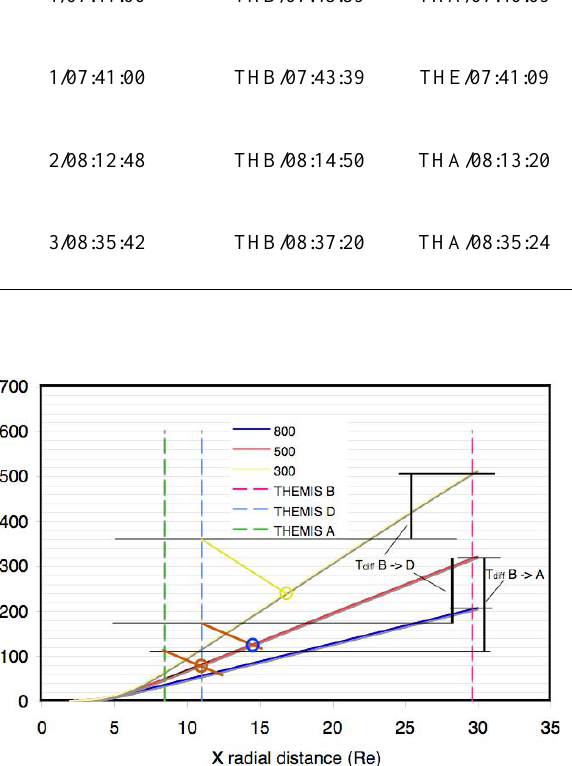
Figure 11. The three curves represent models of the integrated 1/v with 300, 500 and Fig. 11. The three curves represent models of the integrated 1/v with 800 km/s iono-acoustic speeds (yellow, red and blue). The satellite positions for the 300, 500 and 800km/s iono-acoustic speeds (yellow, red and blue). 07:41:00 event of THEMIS A, D, and B are illustrated by the green, blue and red vertical The satellite positions for the 07:41:00 event of THEMIS A, D, and dashed lines. The time difference T diff between the magnetic signature arrivals shown B are illustrated by the green, blue and red vertical dashed lines. The with the black vertical bars. Following the graphical method of deriving X=0 and T= 0 from the signature arrival difference between satellite B and A we can show that using time difference T diff between the magnetic signature arrivals shown the 500 km speed curve X=0 was at 11 Re and is illustrated with a red circle. The blue with the black vertical bars. Following the graphical method of and yellow circles represent the same calculation for the time difference between D and deriving X =0 and T =0 from the signature arrival difference between A for 500 and 300 km/s curves respectively satellite B and A we can show that using the 500km speed curve To examine the inconsistency between the results obtained by comparing the propagation X =0 was at 11 R E and is illustrated with a red circle. The blue and from THEMIS B to A and from THEMIS B to D can be best done by the graphical yellow circles represent the same calculation for the time difference method originally presented in Figure 5. Here in Figure 11 we illustratred the curves between D and A for 500 and 300km/s curves, respectively. describing integrated 1/v for 3 different ionoacoustic speeds. We can estimate the substorm start point ,X=0 and T=0, by comparing the time of arrival of the signatures at two satellites and following the construction technique explained with reference to Figure 5. By considering first the time difference T diff between B and A (shown as a vertical black line on the right) and subtracting it from the ordinates at the position of THEMIS B we find that the 800 km/s curve is too shallow and inconsistent with either the large a time delay or with having the position of the starting point between satellites B and A. Applying the technique to the 500 km/s curve however, we obtain a starting point at about 11 Re-s as illustrated with the red circle. We were hoping to be able to get